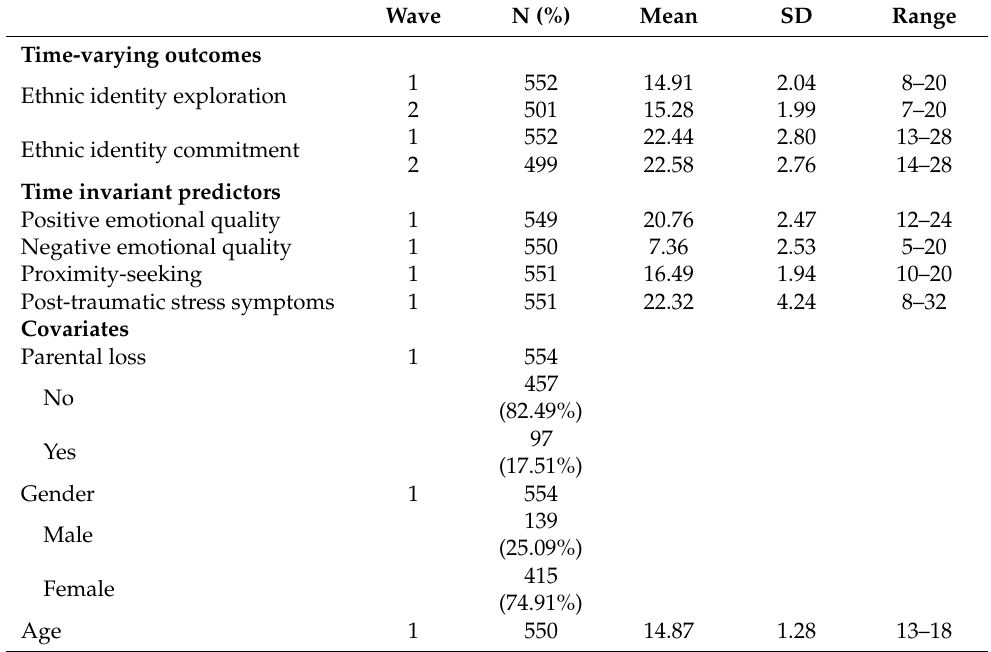
Table 1. Descriptive statistics of variables used in linear mixed models.